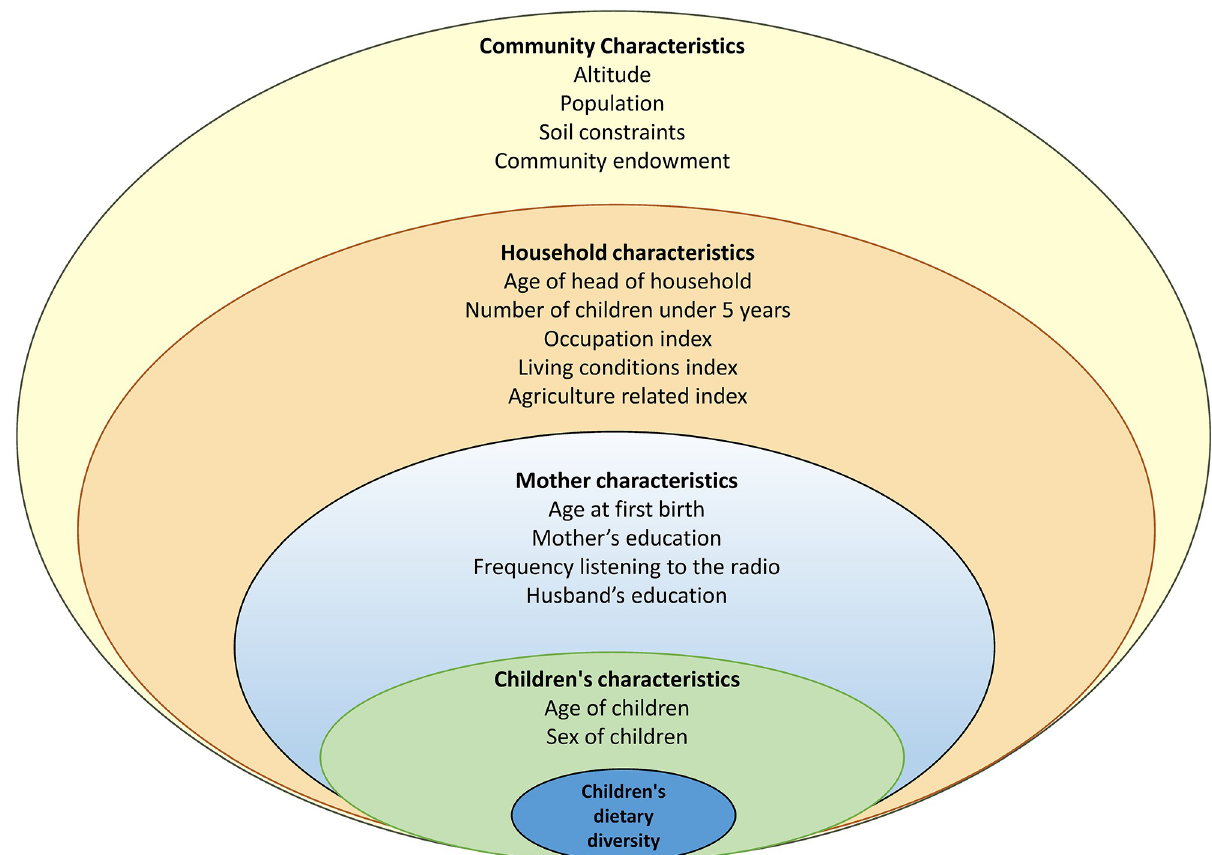
Fig 1. Conceptual framework, Rwanda and Burundi DHS,